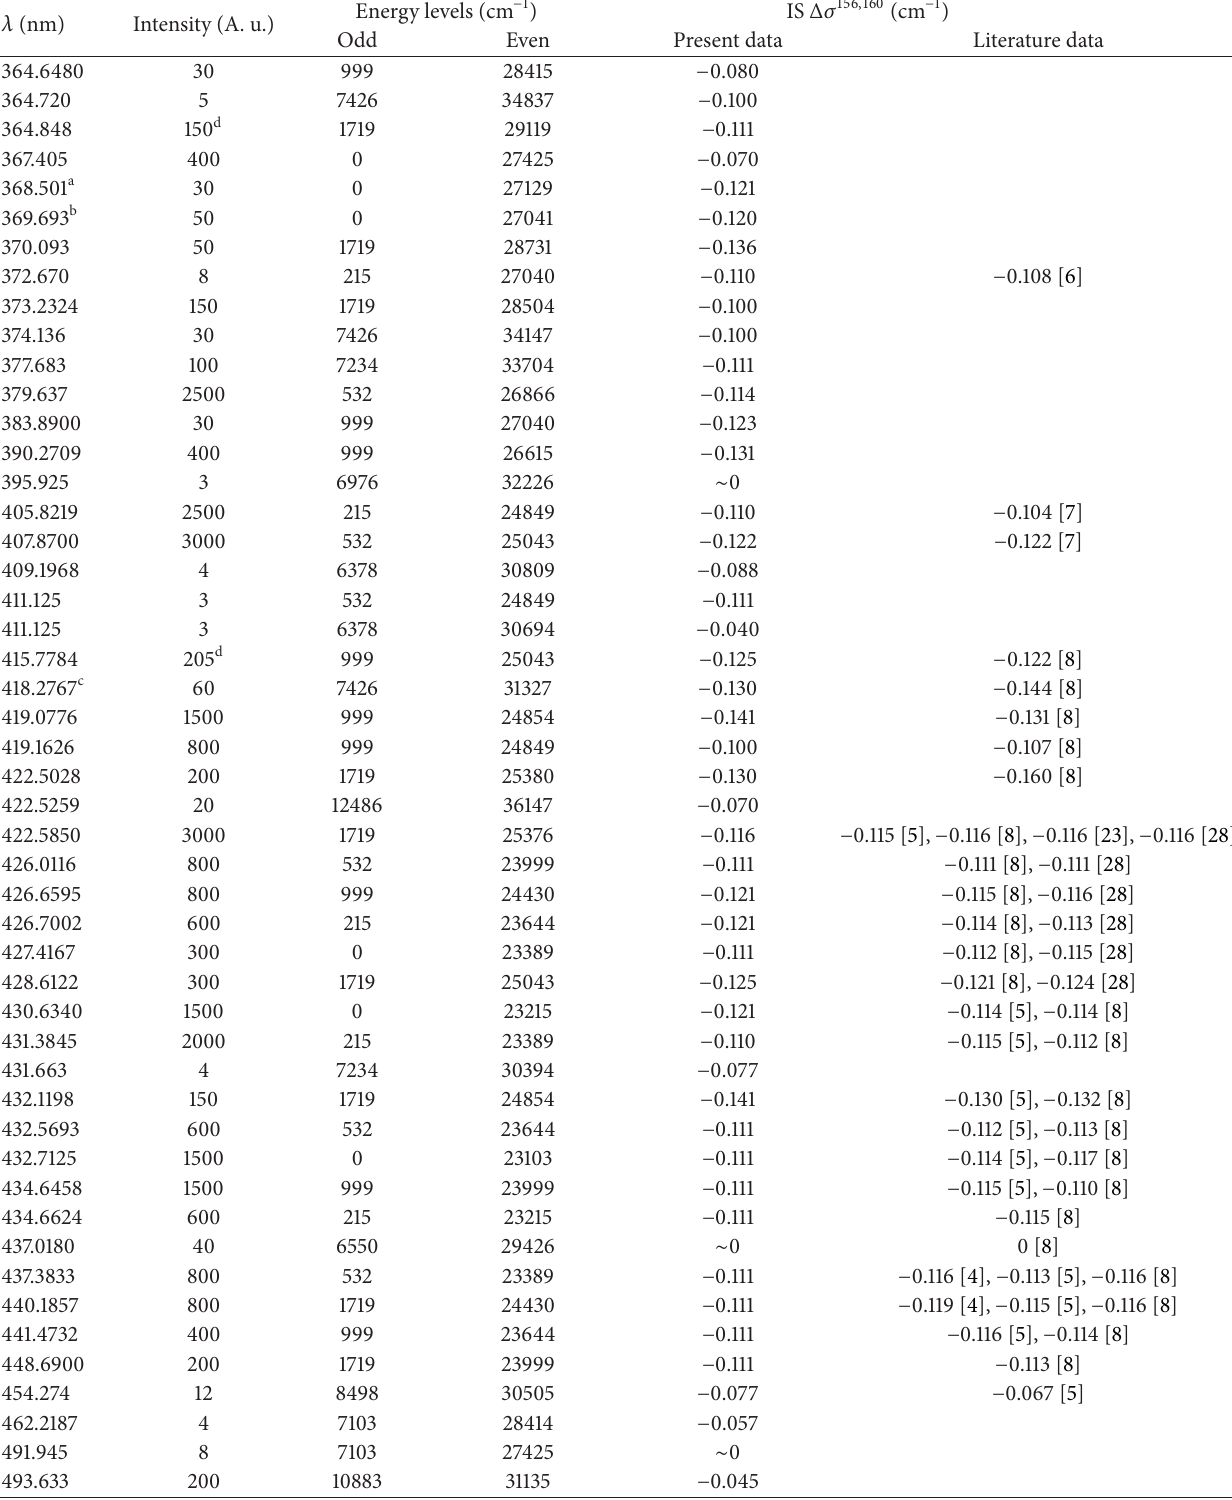
Table 1: Wavelengths, line intensities, and energy level classifications have been taken from Russell [3]. IS Δ𝜎 156,160 (cm − 1 ) in the 49 spectral lines (cm − 1 ) of Gd I covering the region of 3646–4936 ˚A on FTS, source: liquid nitrogen cooled HCL, detector: PMT. Units of measurements were wavelengths (nm), intensities in arbitrary units (A. u.), energy levels (cm − 1 ), and IS (cm − 1 ). The accuracy for lines showing IS greater than 0.060 cm − 1 was ± 3.10 − 3 cm − 1 , and for lines with smaller IS than 0.060 cm − 1 it was ± 5.10 − 3 cm − 1